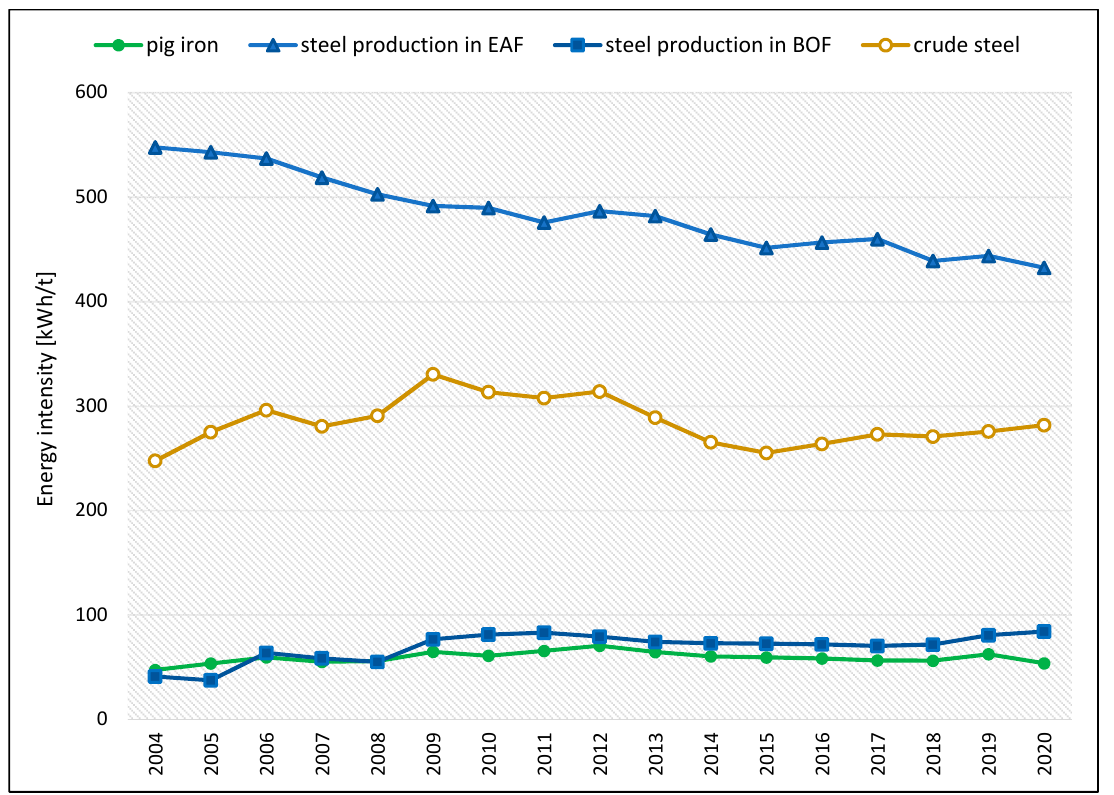
Figure 10. Energy intensity per 1 tonne of steel in Poland from 2004 to 2020. Source: Own elaboration.